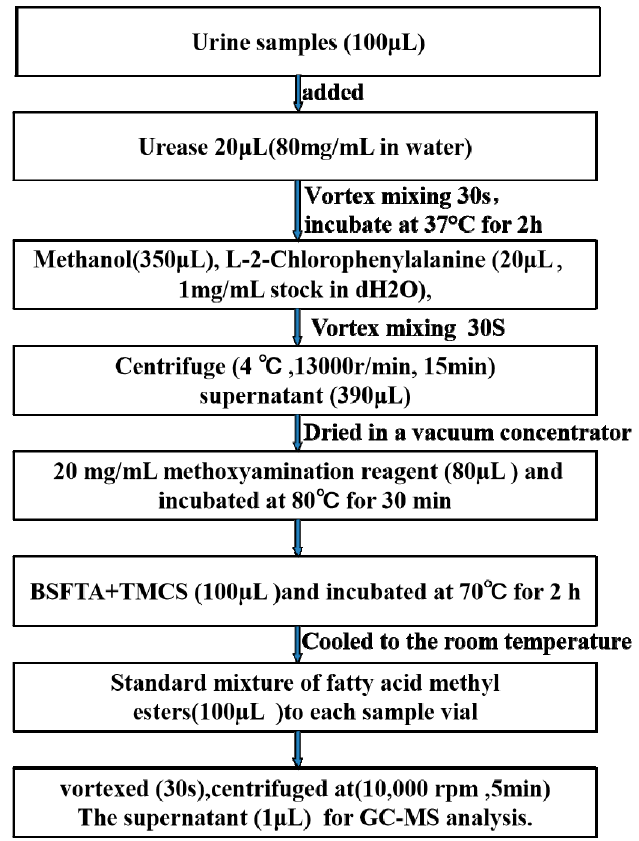
Figure 10. The urine sample flow- processing.